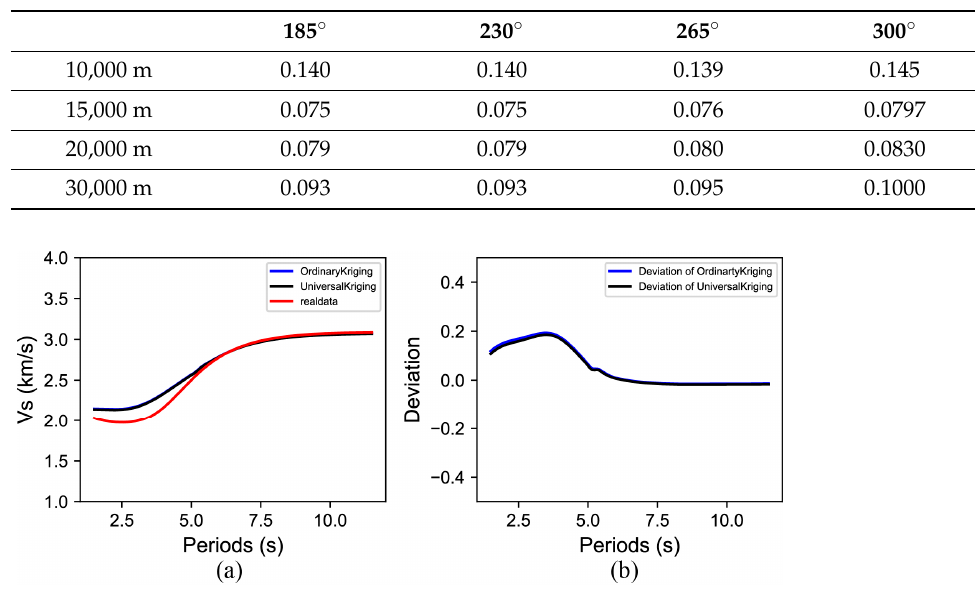
Figure A2. Comparison of dispersion curve interpolation results (127.91° E, 41.94° N ). The blue curve indicates the ordinary kriging results, while the black curve indicates those of universal kriging: ( a ) Comparison of the dispersion curves; and ( b ) deviation of the OK (blue) or UK (black) results.